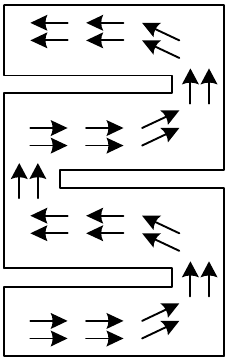
Figure 2. Schematic diagram of surface current distribution on rectangular patch with slots.